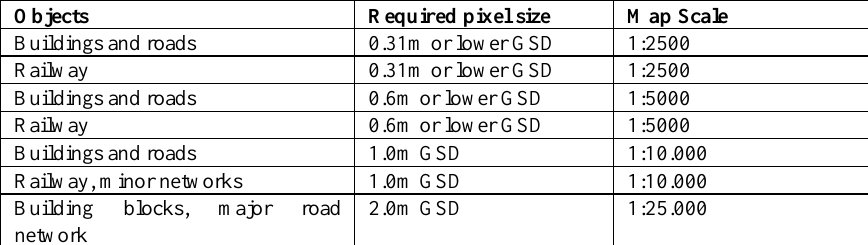
Table 2. Required GSD for topographic mapping based on panchromatic